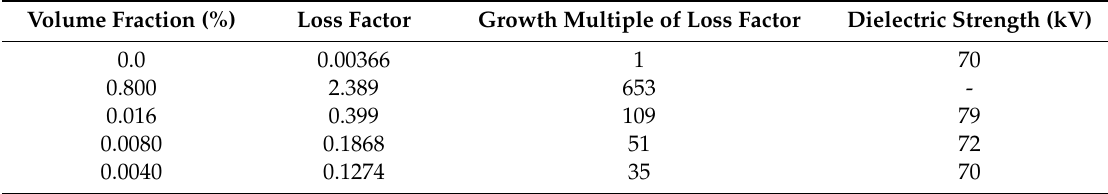
Table 2. Electrical properties of magnetic fluids compared with those of pure insulating